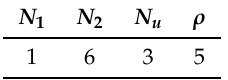
Table 5. Parameters of the model-based predictive controller for the Coupled Tanks Liquid Level control.